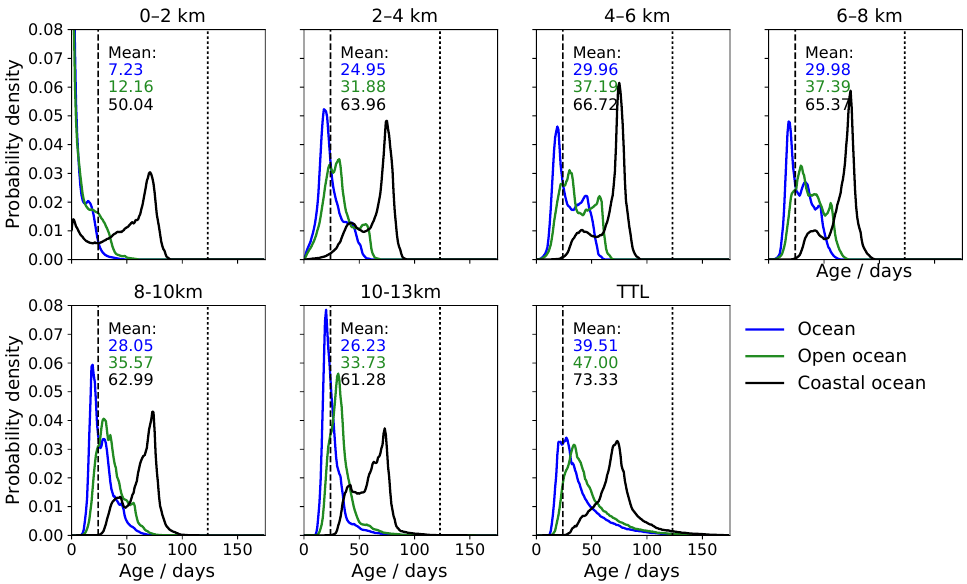
Figure 8. Probability density functions of the age of air A for (blue) total ocean, (green) open oceans, and (black) coastal ocean tracers, described as 2km altitude regions from the surface to the TTL (13km to the tropopause) averaged over the whole study domain